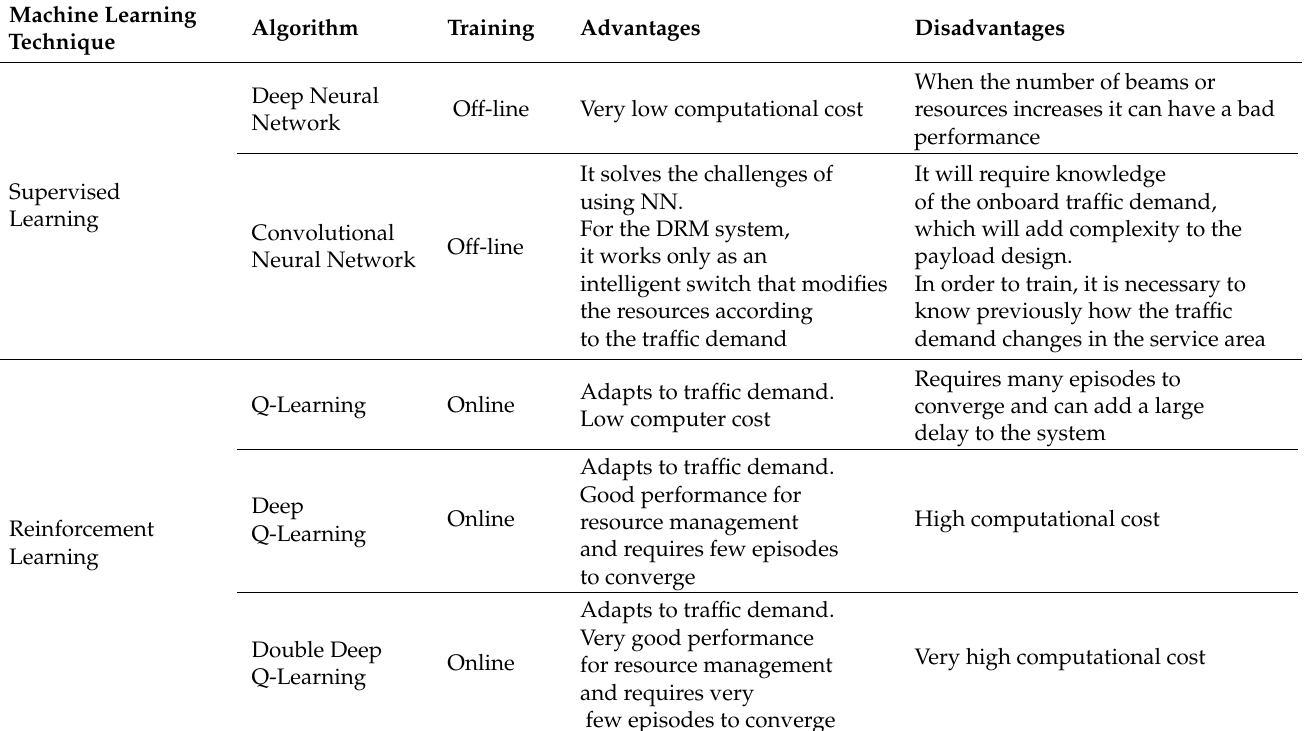
Table 5. Main advantages and disadvantages of different machine learning techniques for radio resource management in multibeam SatCom